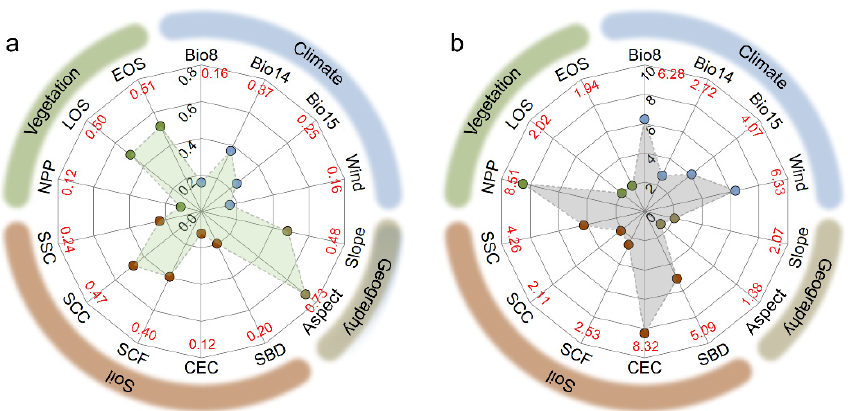
Figure 2. The results of the multicollinearity analysis of the environmental covariates ( a ) TOL, ( b ) VIF. Climate: Bio8 (mean temperature of wettest quarter), Bio14 (precipitation of driest month), Bio15 (precipitation seasonality); Wind (wind speed); Geography: Slope, Aspect; Soil: SBD (soil bulk density), CEC (cation exchange capacity at pH7), SCF (soil coarse fragments), SCC (soil clay content), SSC (soil silt content); Vegetation: NPP (net primary production), LOS (length of the growing season), EOS (end of the growing season). The specific values of each indicator TOL and VIF are in red.